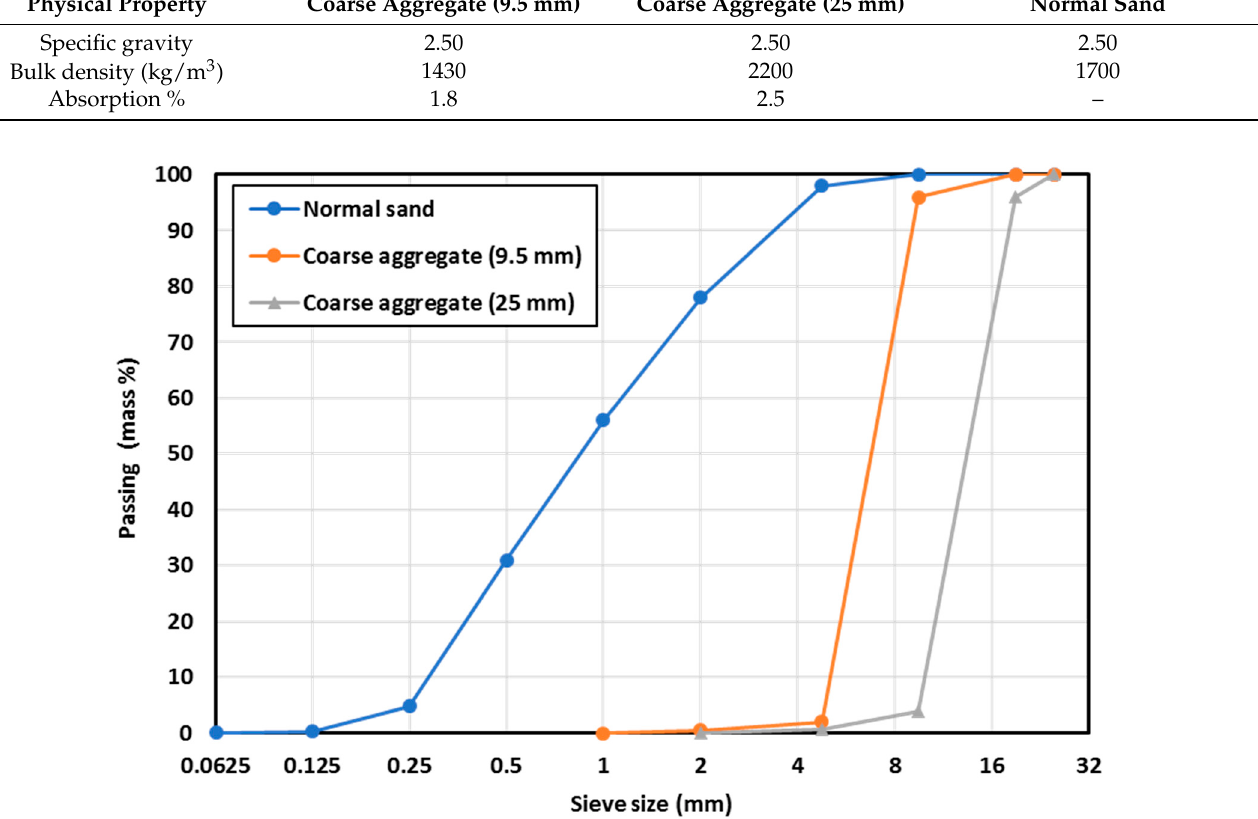
Figure 2. Grading curves for all aggregates used.